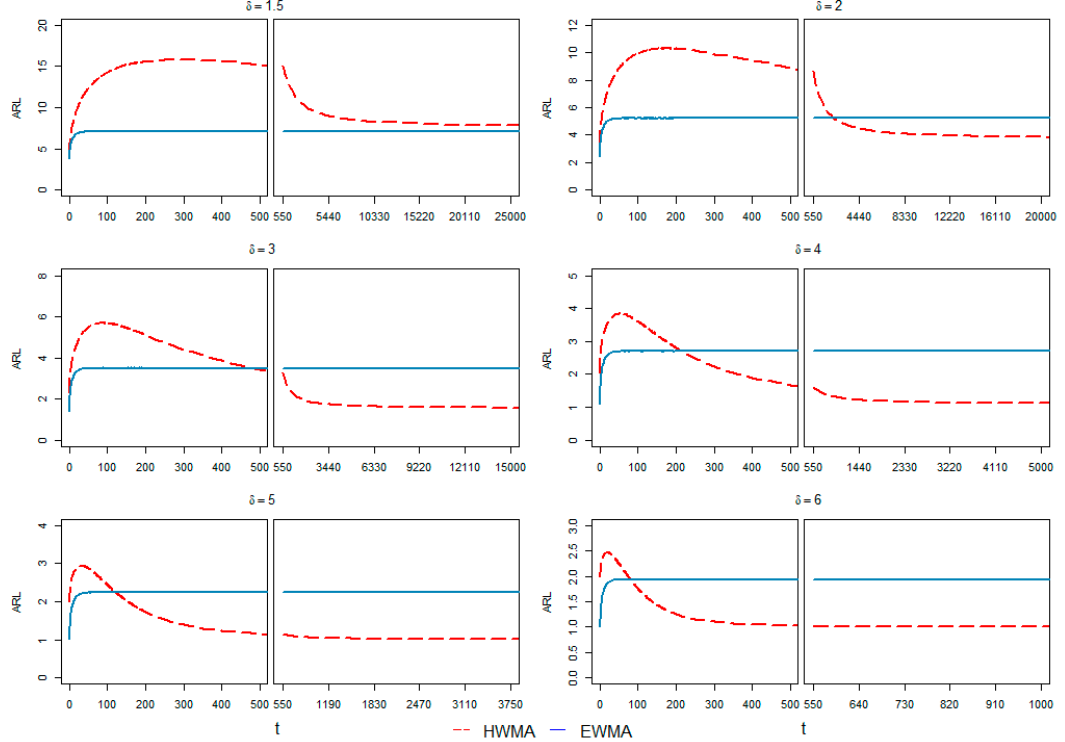
Figure 5. CED curves for the HWMA and EWMA charts under moderate to large shifts at 𝜆 = 0.05 with respect to time points (𝑡) .